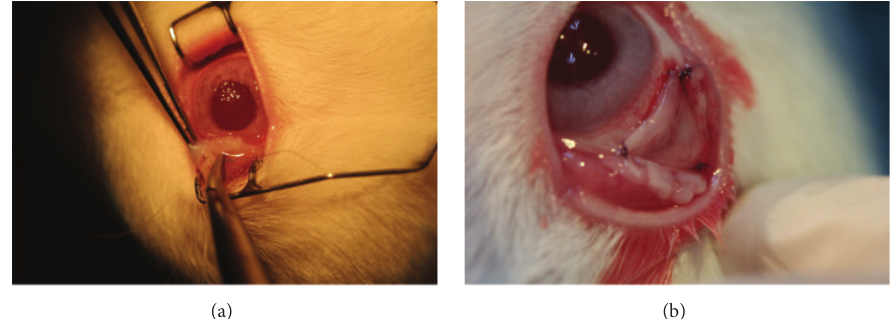
Figure 3: (a) PRF membrane was placed on the bare sclera and secured with 7-0 absorbable suture. (b) The immobilization of the PRF membrane over the defective